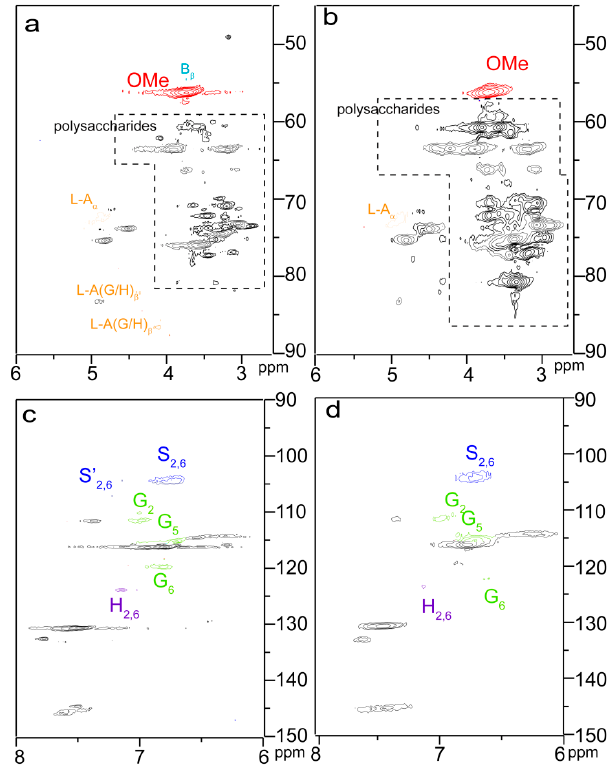
Figure 4. 2D HSQC spectra of unmodified (B0, a , c ) and esterified (B3, b , d ) bagasse.